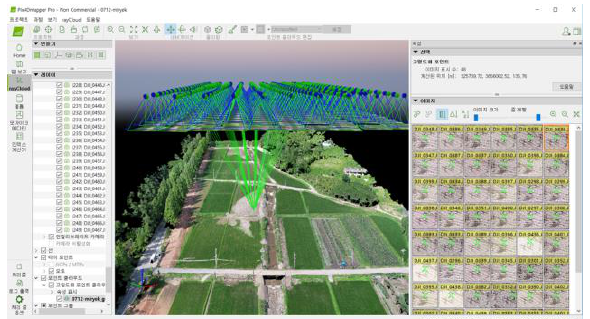
Figure. 8. Flood damage analysis using drone